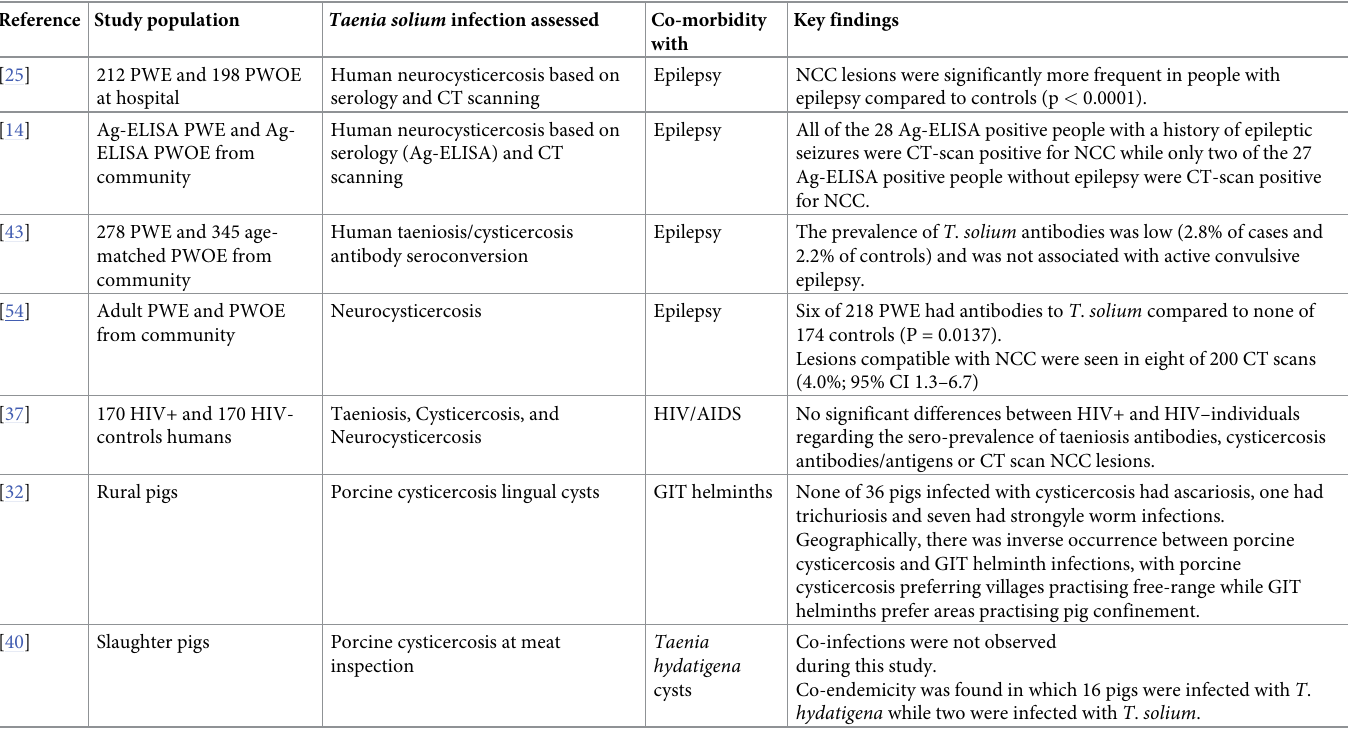
Table 4. Co-morbidity of Taenia solium infections with other infections in Tanzania,